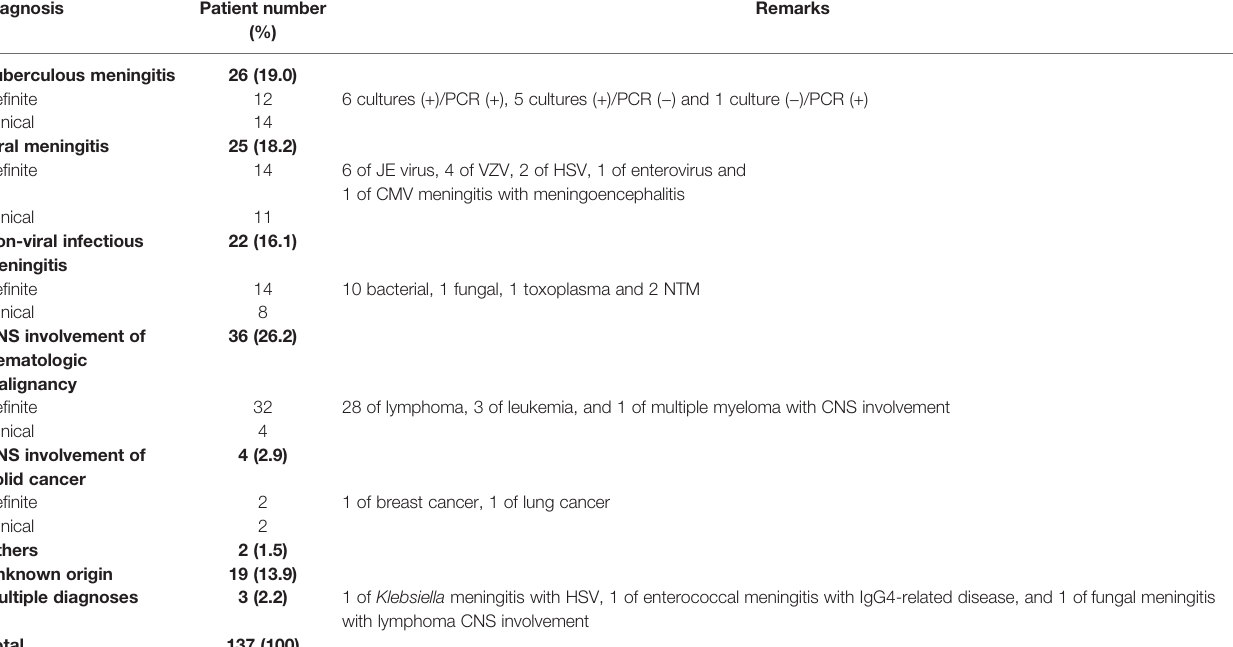
TABLE 1 | De fi nite and clinical diagnoses of patients with elevated ADA ( ≥ 10 IU/L). Diagnosis Patient number (%)